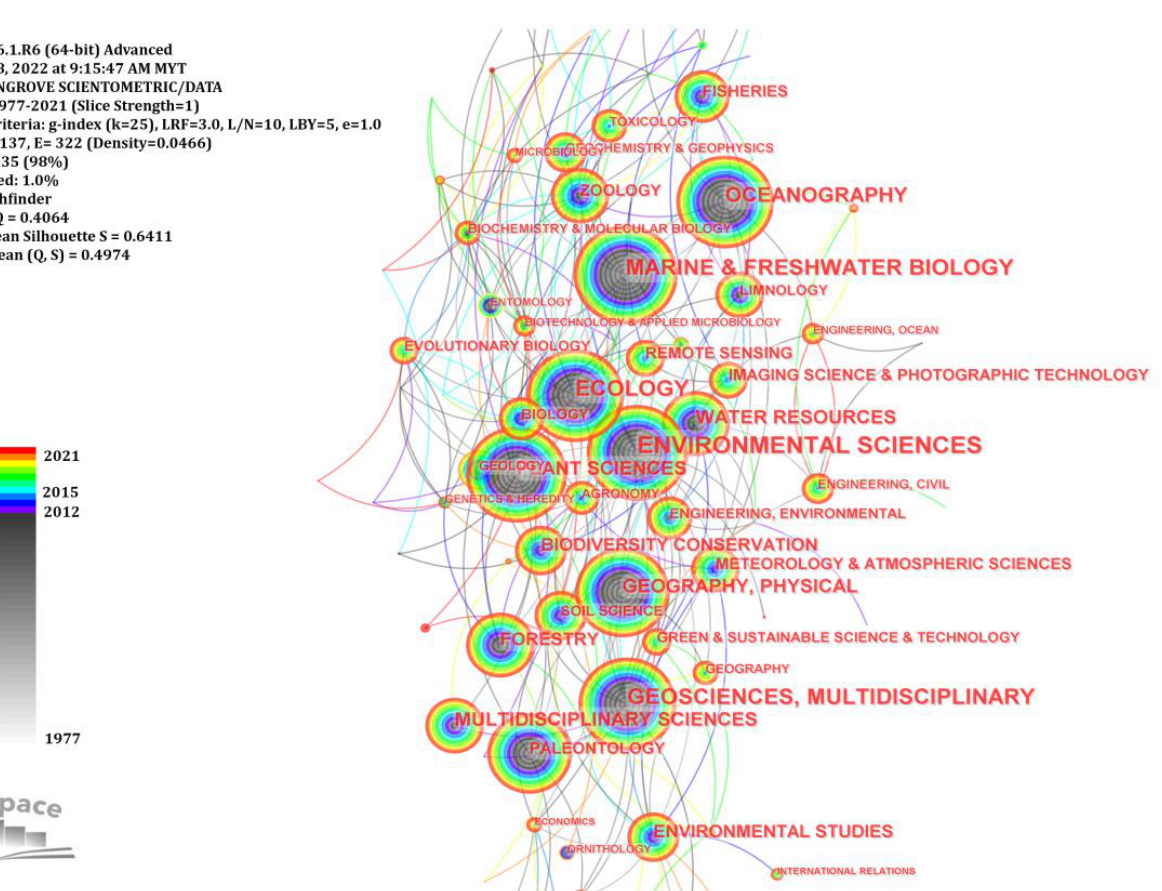
Figure 5. Network links between research disciplines. The lines connecting the nodes represent the strength of connections between research fields, with thicker lines indicating a higher intensity of connections. The size of the nodes signifies the frequency of co-occurrence in the subject category. The nodes are color-coded to represent the year of publication, e.g., red representing 2021, yellow representing 2019, blue representing 2015, and purple representing 2012.